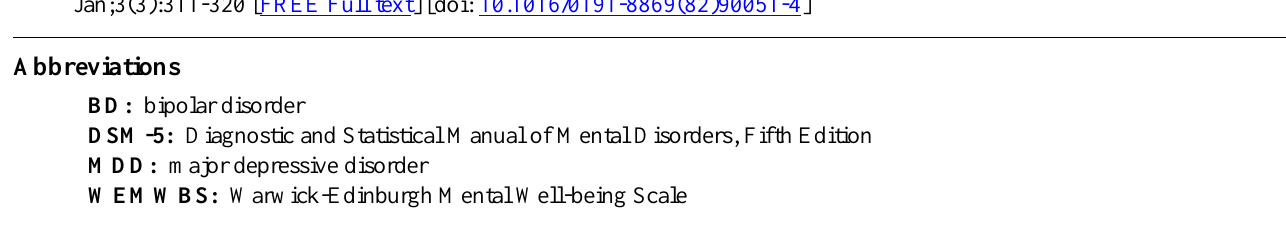
WEMWBS: Warwick-Edinburgh Mental Well-being